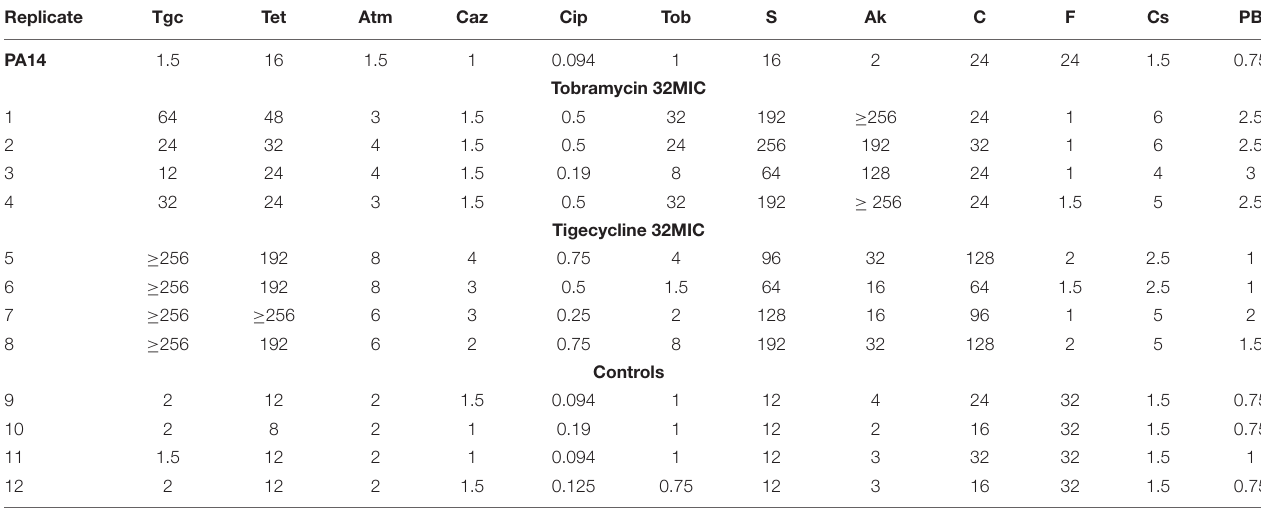
TABLE 1 | MICs ( µ g/ml) of antibiotics of different structural families in the populations evolved at 32MIC tobramycin and tigecycline. Replicate